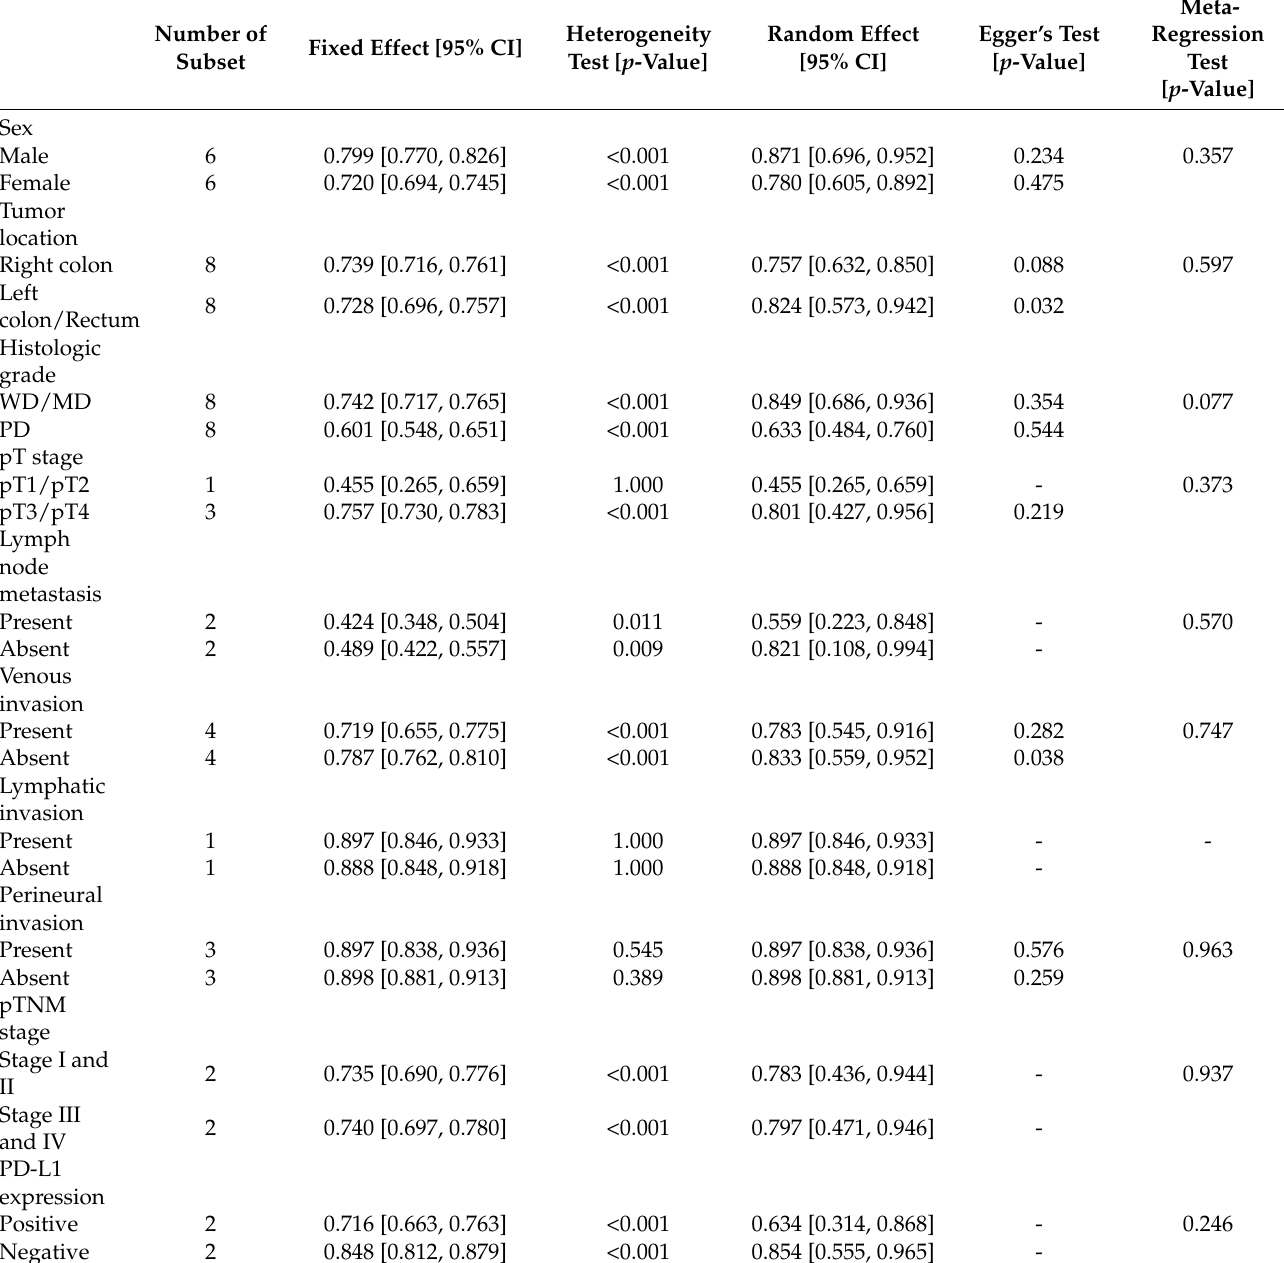
Table 3. Comparisons of CDX2 expression rates between various clinicopathological